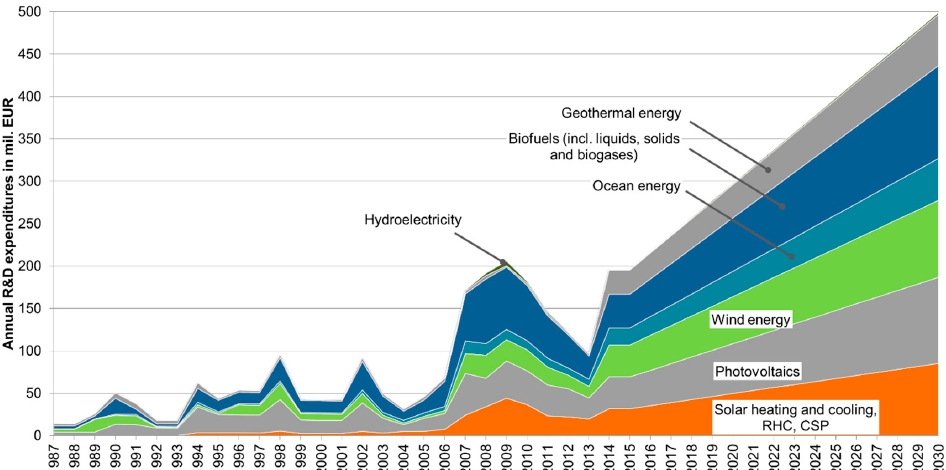
Figure 4. Renewable energy sources R&D expenditures of the EC from 1987 to 2013 and estimated until 2030 (Mil. EUR, advanced scenario) (2014 prices and exc. rates).